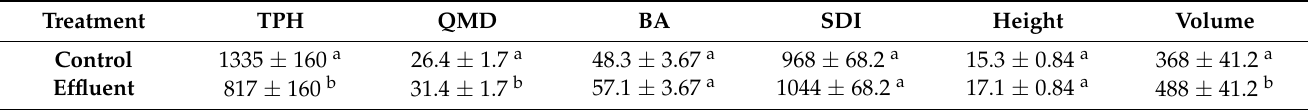
Table 4. Descriptive statistics (LS mean ± SE) of stand parameters [TPH (Trees per hectare); QMD (Quadratic Mean Diameter); BA (Basal Area); SDI (Stand Density Index); Height and Volume] by treatment at the five water reuse facilities.